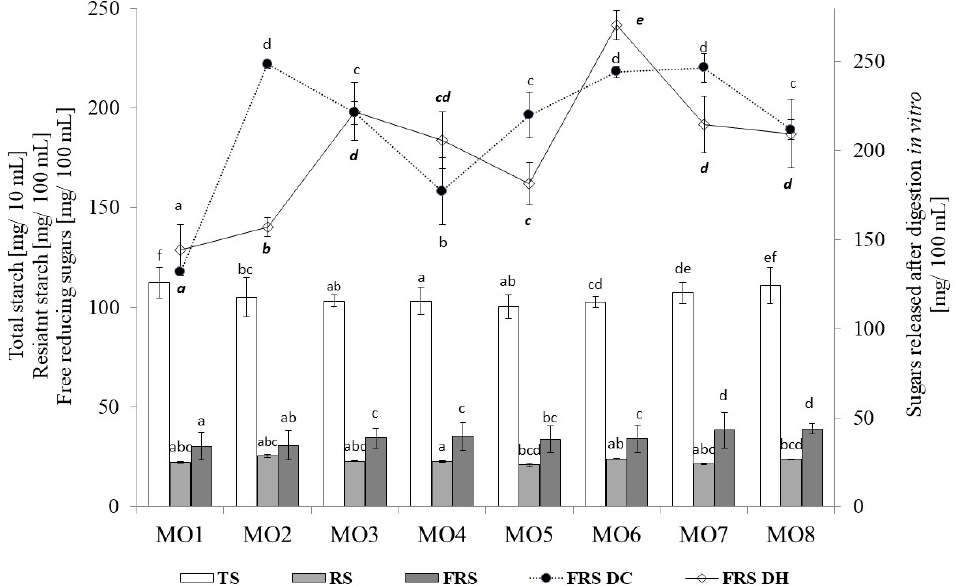
Figure 2. Total starch, resistant starch, and free reducing sugars, in the powders and after digestion in vitro. MO1—control beverage; MO2—beverage enriched with 10% raspberry; MO3—beverage enriched with 10% strawberry; MO4—beverage enriched with 10% apple; MO5—beverage enriched with 5% raspberry and 5% strawberry; MO6—beverage enriched with 5% raspberry and 5% apple; MO7- beverage enriched with 5% strawberry and 5% apple; MO8- beverage enriched with 4% apple, 3% raspberry, and 3% strawberry; TS—total starch, RS—resistant starch, FRS—free reducing sugars, FRS DC—free reducing sugars in digested beverages rehydrated at 20 ◦ C, FRS DH—free